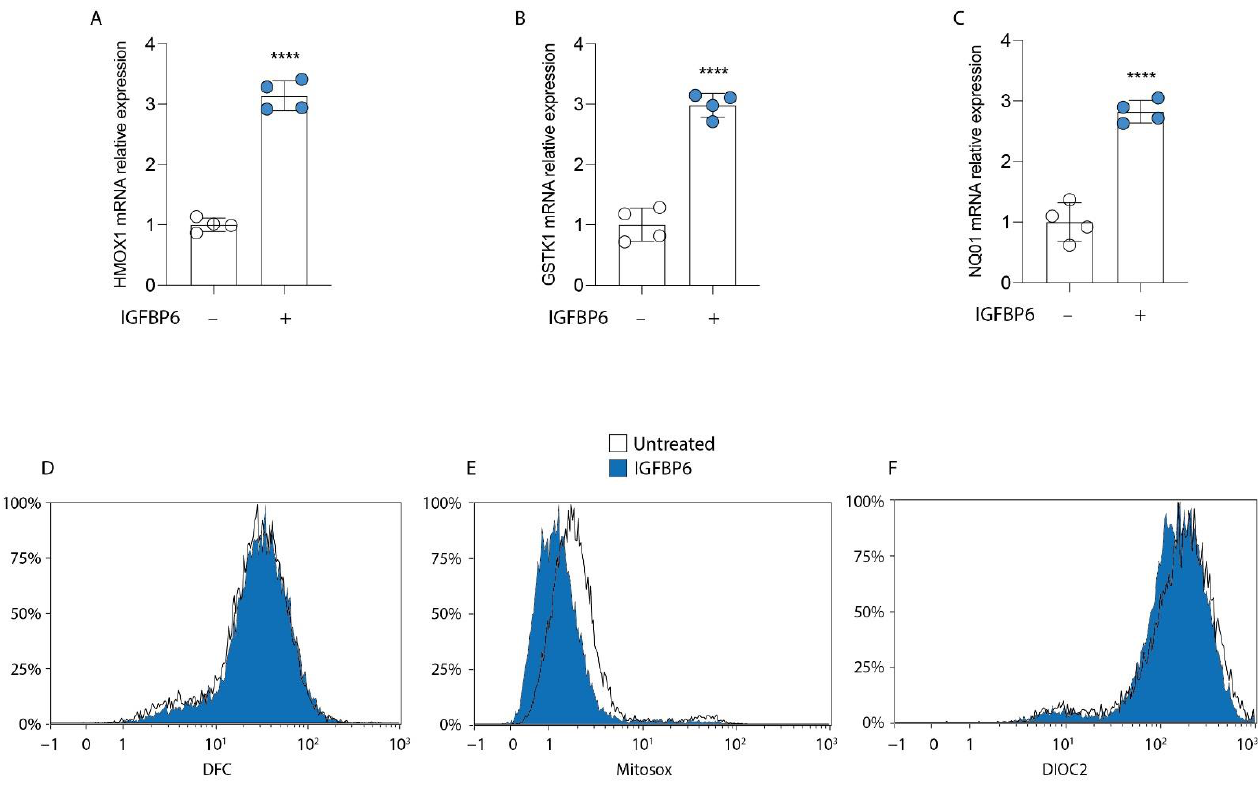
Figure 5. IGFBP6 induces an antioxidant response in MDA-MB-231 cells. Evaluation of relative mRNA expression levels of HMOX1 ( A ), GSTK1 ( B ) and NQ01 ( C ), following 24 h of IGFBP6 (800 ng/mL) treatment. The calculated value of 2 - ΔΔCt in untreated controls is 1. Data are expressed as mean ± SD of at least four independent experiments. **** p < 0.0001. Representative plots of ROS ( D ) and mitochondrial ROS ( E ) production using DCF and MitoSox probe, following 24 h of IGFBP6 exposure. Representative plot of mitochondrial membrane potential ( F ) evaluated with DiOC2 staining, following 24 h of IGFBP6 treatment. Plots are representative of at least four independent experiments.